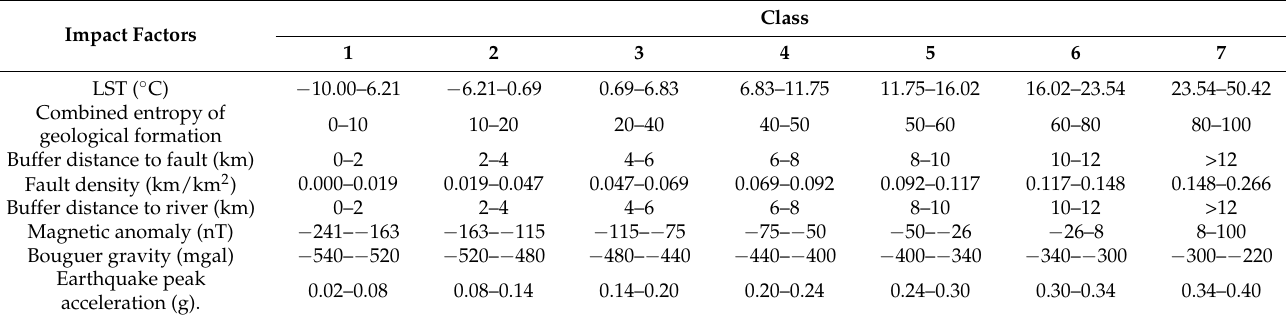
Table 1. Reclassification threshold for impact factor maps.